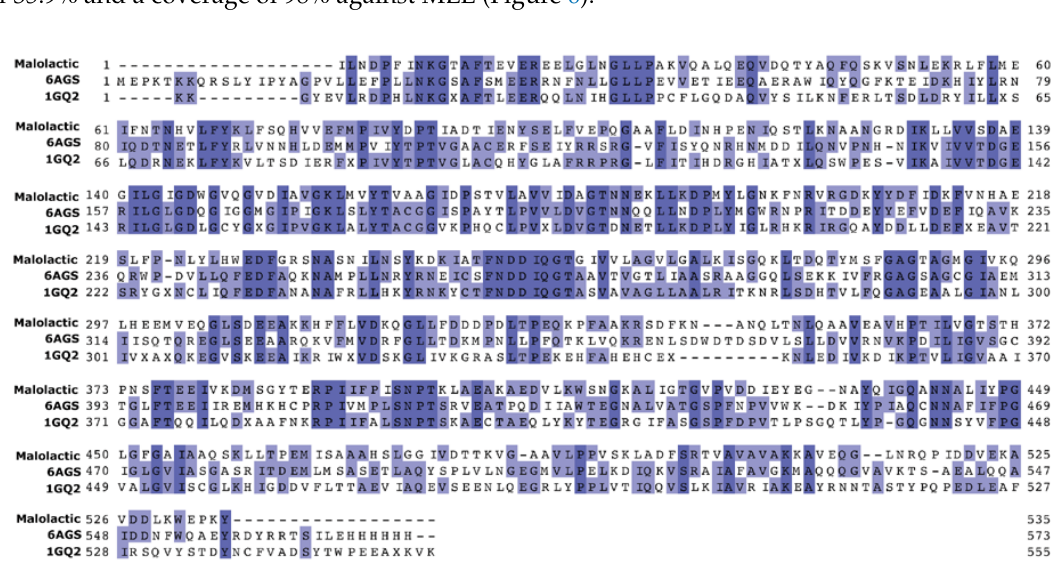
Figure 6. Sequence alignment of malolactic enzyme from Oenoccocus Oeni , malic enzyme from pigeon liver (PDB entry 1GQ2) and malic enzyme from E. coli (PDB entry 6AGS).